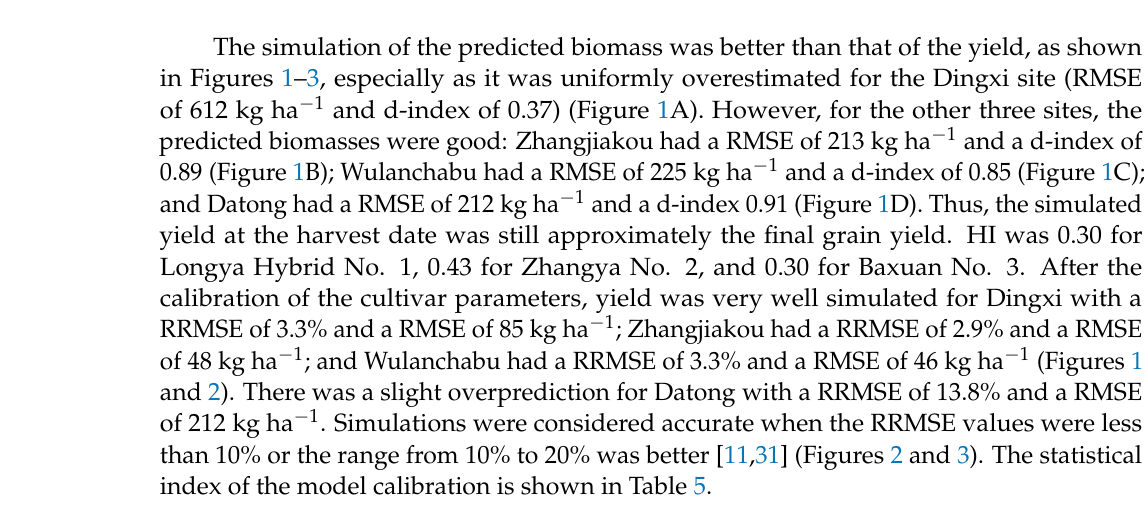
Table 5. Statistical summary for calibration of the SIMPLE-Flax